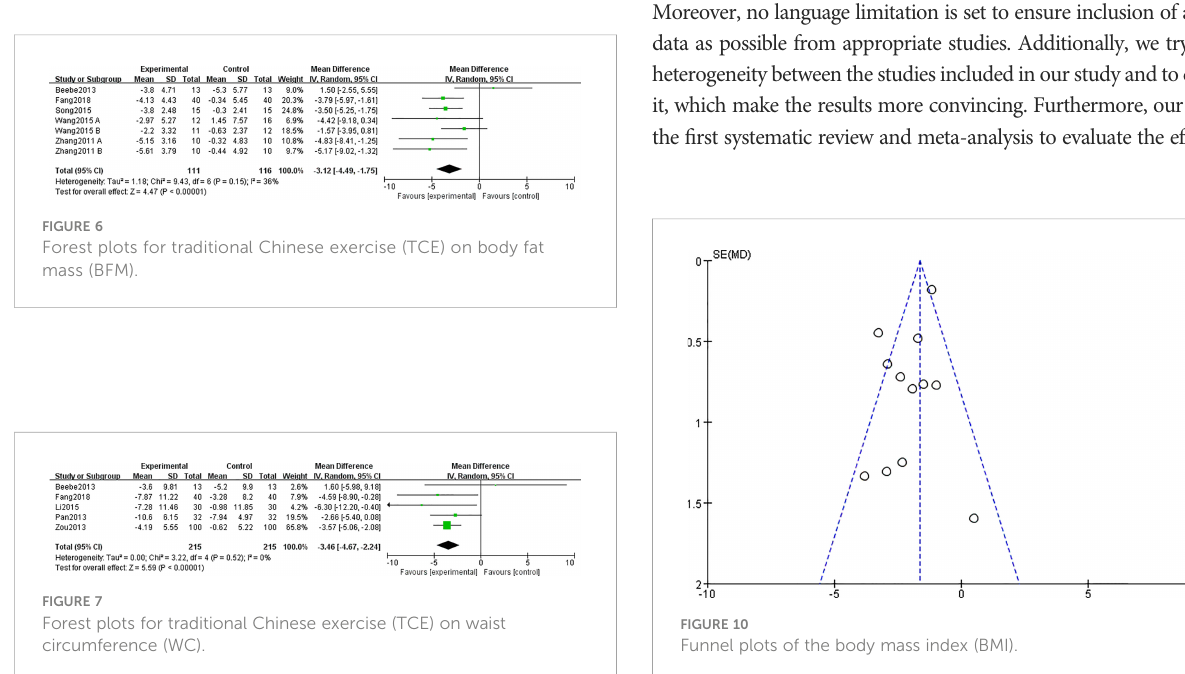
FIGURE 7 Forest plots for traditional Chinese exercise (TCE) on waist circumference (WC).